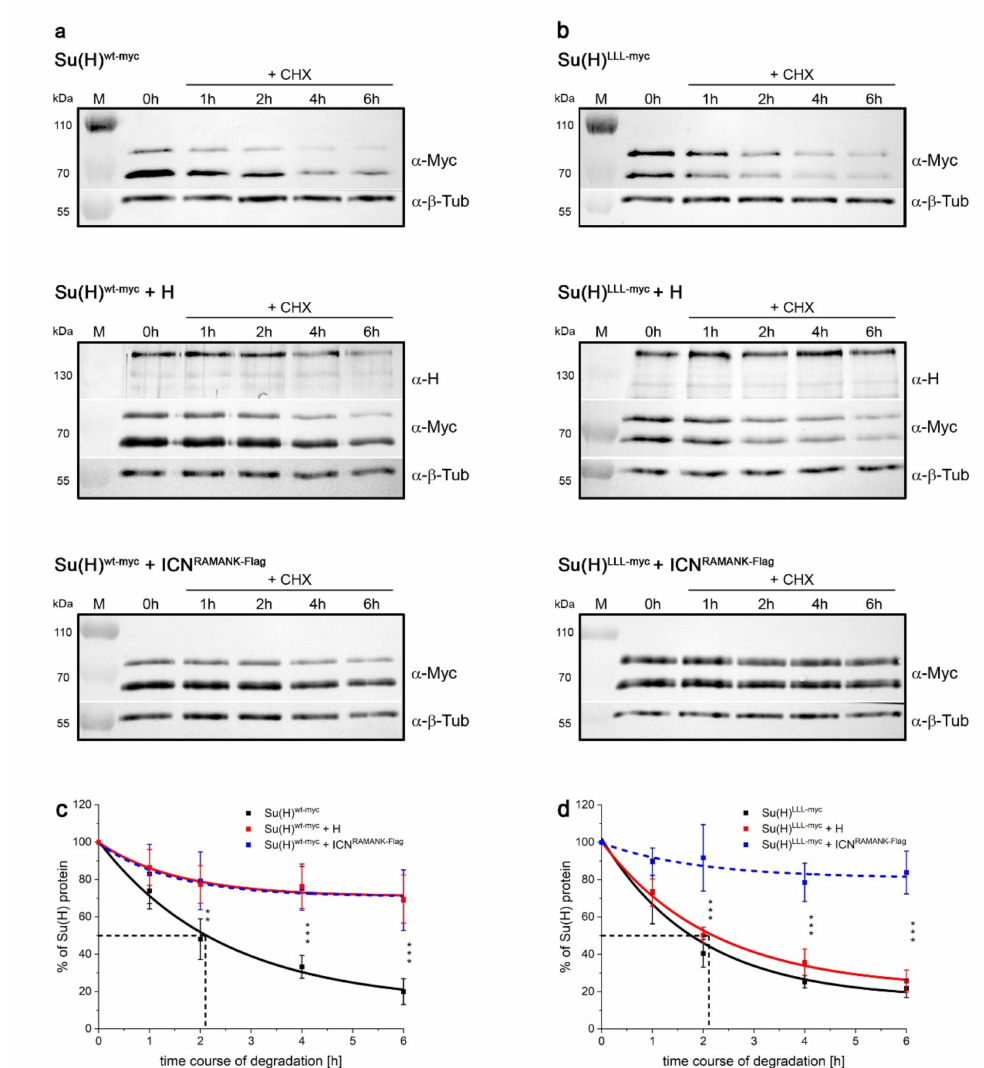
Figure 5. ( a ) Su(H) wt-myc protein and ( b ) Su(H) LLL-myc protein expressed in HeLa RBPJ KO cells, in the presence or absence of either co-repressor H or co-activator ICN RAMANK as indicated. Translation was inhibited by addition of cycloheximide (CHX), and proteins extracted thereafter at the indicated time points. Su(H) was detected with anti-myc antibodies. Western blots were cut to monitor respective protein expression simultaneously with adequate primary antibodies as indicated. Beta- Tubulin (ß-Tub) served as internal control for quantification. Representative Western blots are shown. ( c , d ) Quantification of Su(H) protein levels over time in the presence or absence of either H or ICN RAMANK , relative to beta tubulin, from five independent experiments performed under identical conditions. SD is shown; significant differences are observed relative to Su(H) wt-myc ( c ) or to Su(H) LLL-myc with or without H ( d ) (*** p < 0.001; ** p <